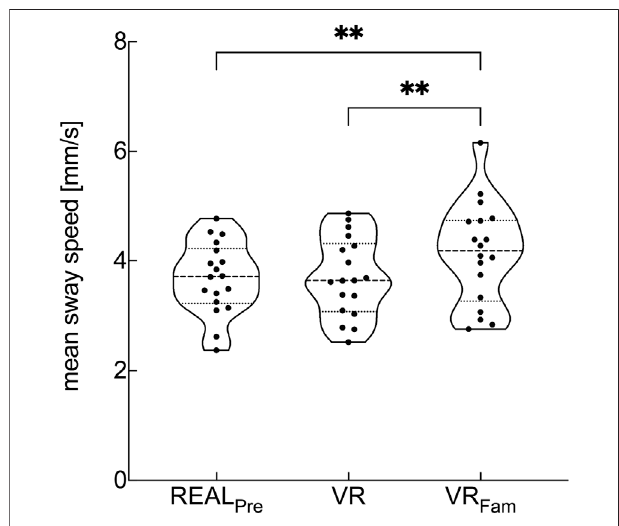
FIGURE 2 | Violin plots of mean COM sway speed for conditions with reliable visual input preceding the optic fl ow perturbations. Visual conditions are realenvironment(REAL Pre ),virtualreplica oftherealenvironment(VR),and virtual replica of the real environment after 3-min familiarization to VR (VR Fam ). Violin plots represent data from each subject and show median values (dashed horizontal line), lower and upper 25th and 75th percentile values (dotted lines) and error bars (spanning smallest to largest individual values). ** p <